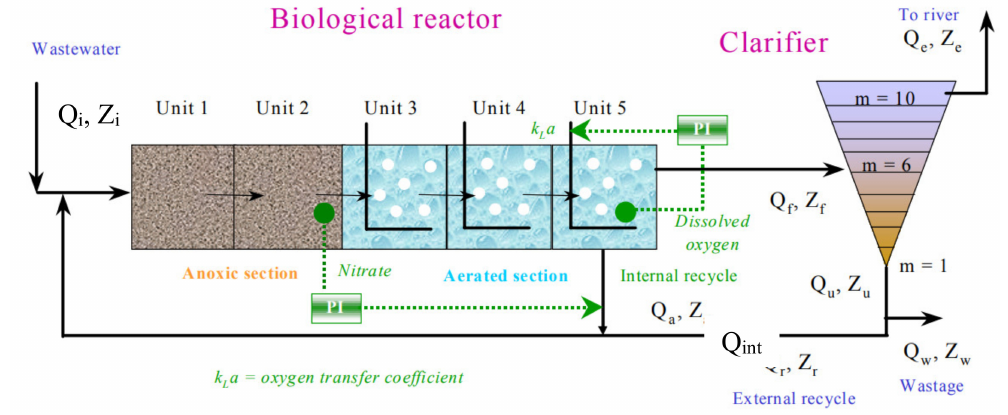
Figure 2. Benchmark simulation model